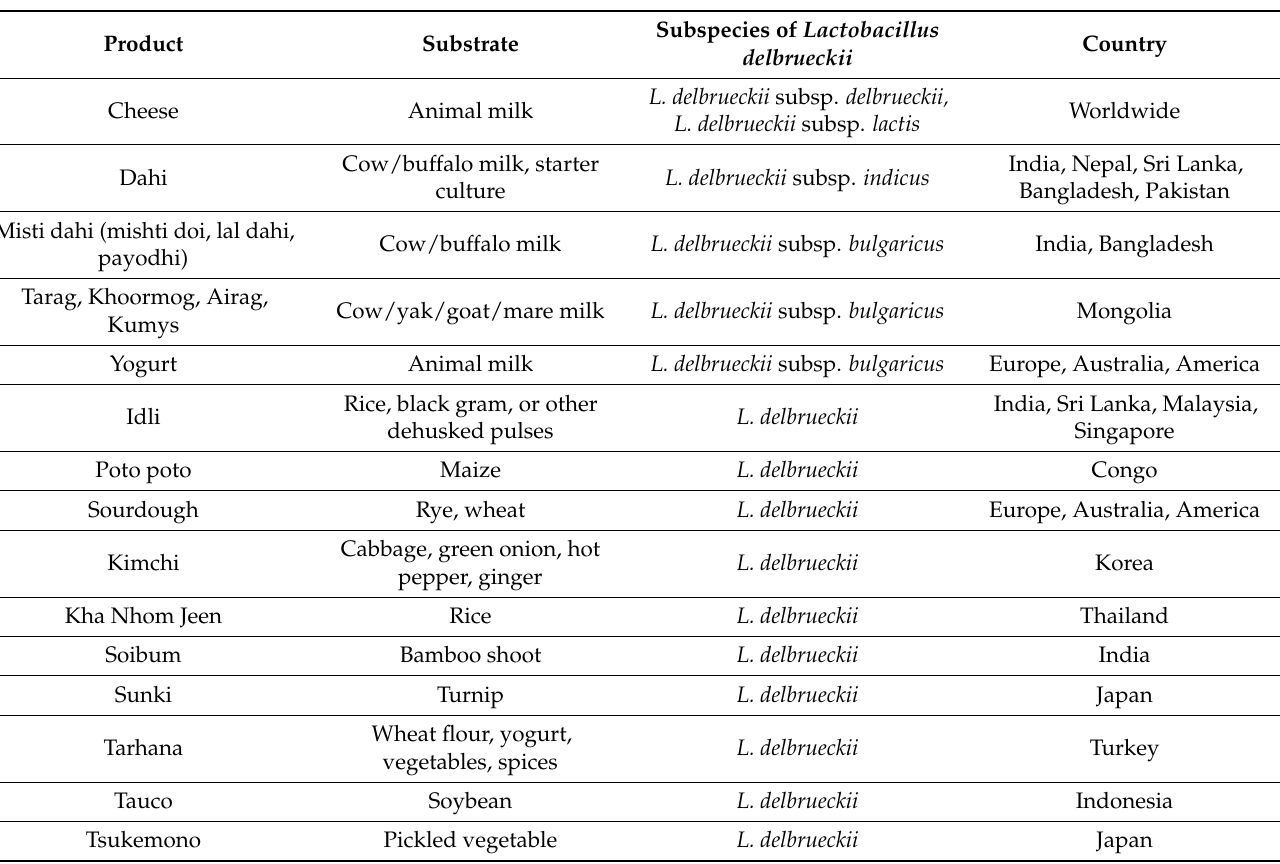
Table 1. Subspecies of Lactobacillus delbrueckii isolated from various fermented food products (reviewed by [7,20,21]).